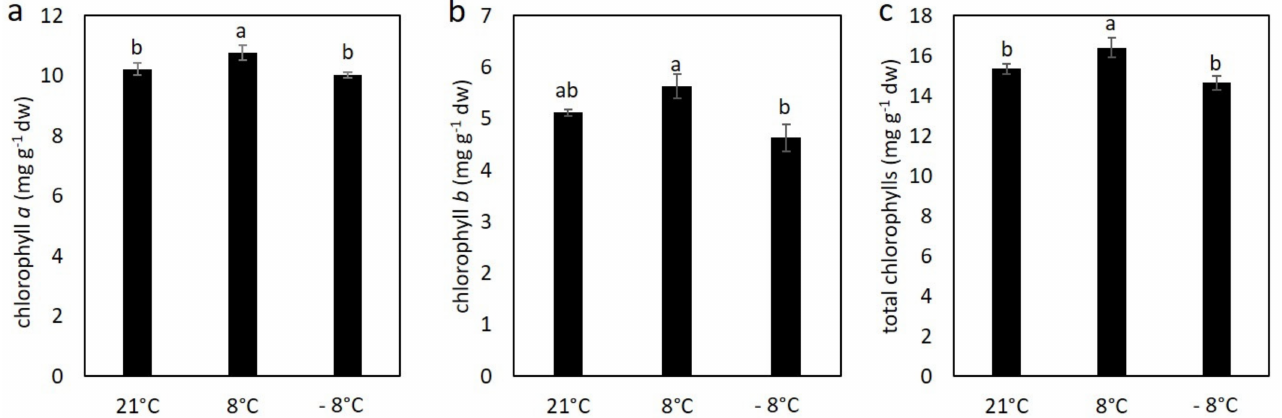
Figure 3. The content of chlorophyl a ( a ), chlorophyl b ( b ) and total chlorophylls ( c ) in kale exposed to low temperatures. Value marked with different letters are significantly different at p < 0.05.